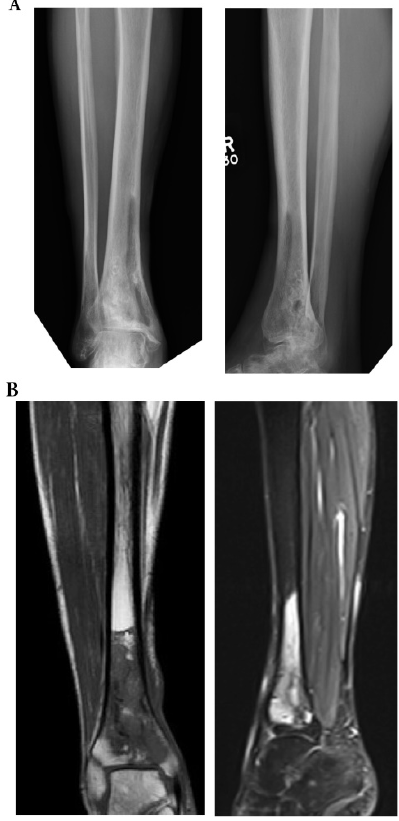
Figure 1. Pre-operative radiograph (a) and MRI (b) suggestive of Cierny and Mader Stage 3 osteomyelitis of the lower tibia.